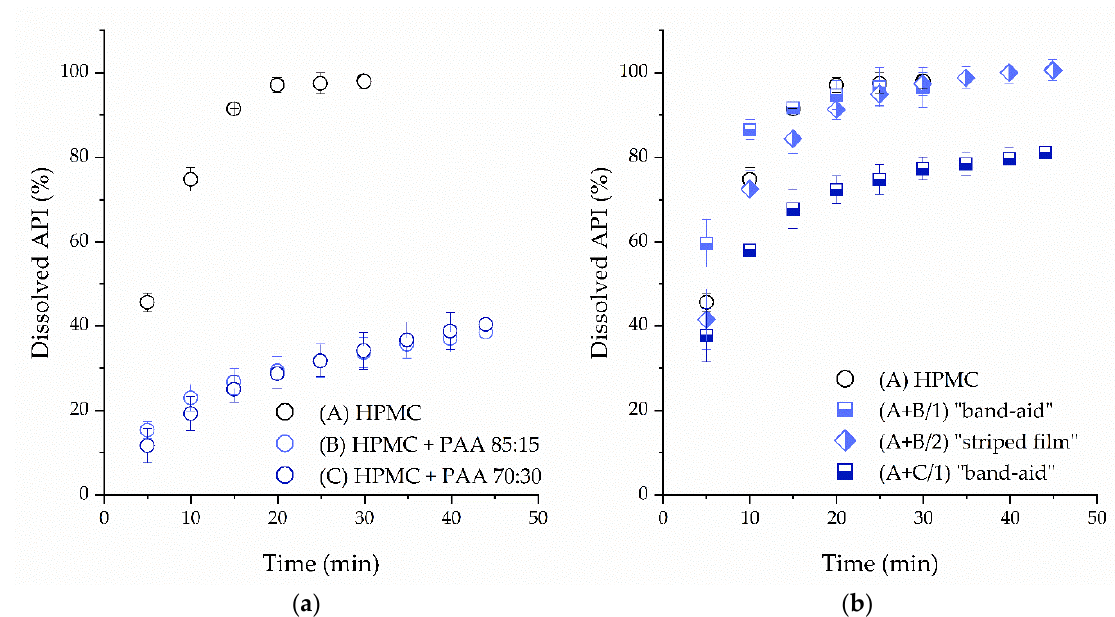
Figure 11. Dissolution profiles of ( a ) mucoadhesive conventional and ( b ) tandem films in compari- son to the HPMC “reference” film ( n = 3, mean ± sd). to the HPMC “reference” film ( n = 3, mean ±